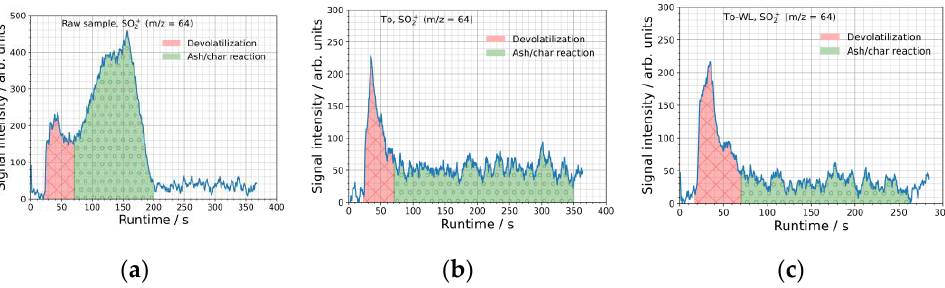
Figure 4. Intensity-time profiles of 23 CO 2++ , 34 H 2 S + , 35 Cl + , 36 HCl + , 37 Cl + , 38 HCl + , 39 K + , 47 PO + , 55 KO + , 58 NaCl + , 60 COS + , 62 P 2+ , 63 PO 2+ , 64 SO 2+ , 74 KCl + , 81 Na 2 Cl + , 97 NaKCl + , 106 P 2 O 4+ , 113 K 2 Cl + , and 122 P 2 O 5+ gained for raw wheat straw at 950 °C in 80 vol% He, 15 vol% H 2 O and 5 vol% CO 2 . Recorded mass spectra of sulfur dioxide are presented in Figure 5.